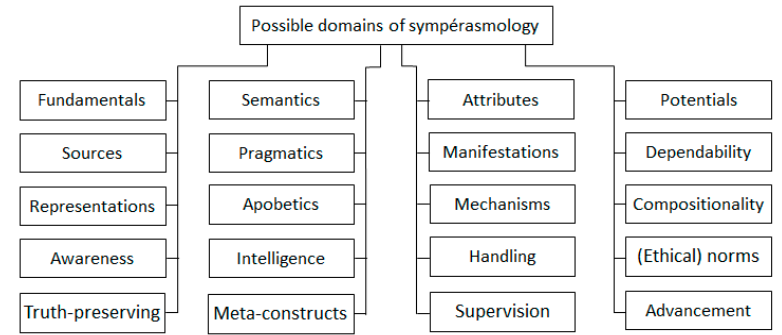
Figure 5. Possible domains of sympérasmological investigations.